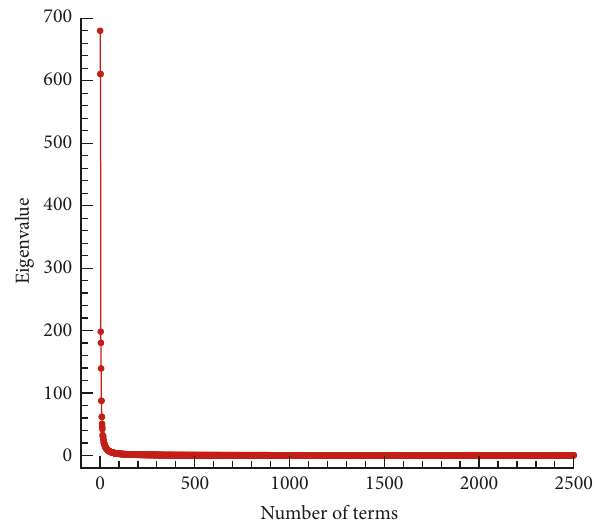
Figure 5: Eigenvalues of KL expansion.